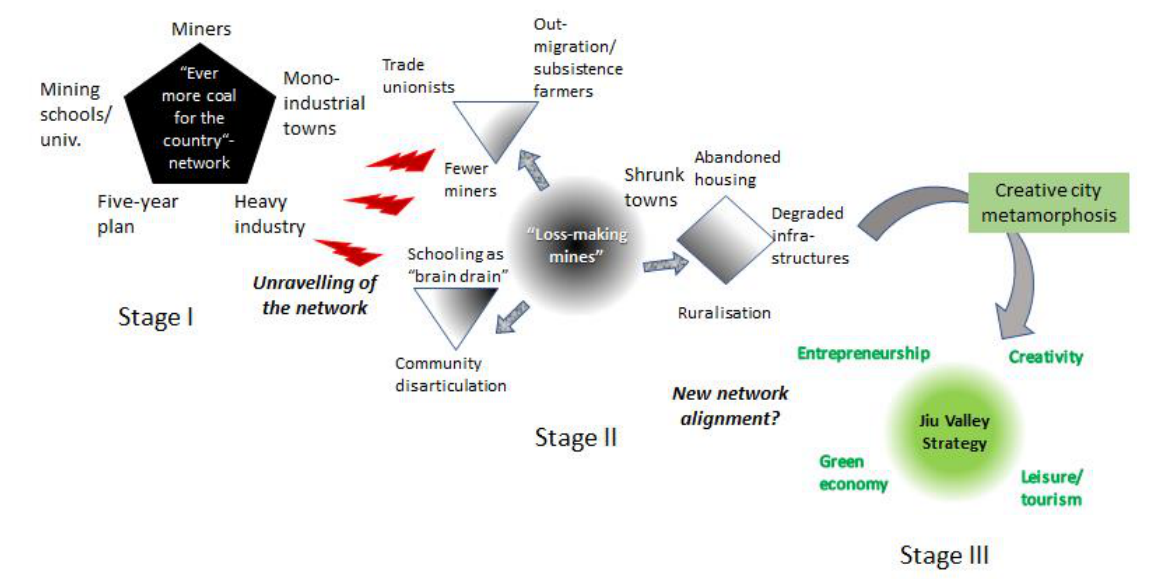
Figure 2. Stages of misalignment of the “Jiu Valley development” translation. Source: the authors based on the work of Callon and Law [13].